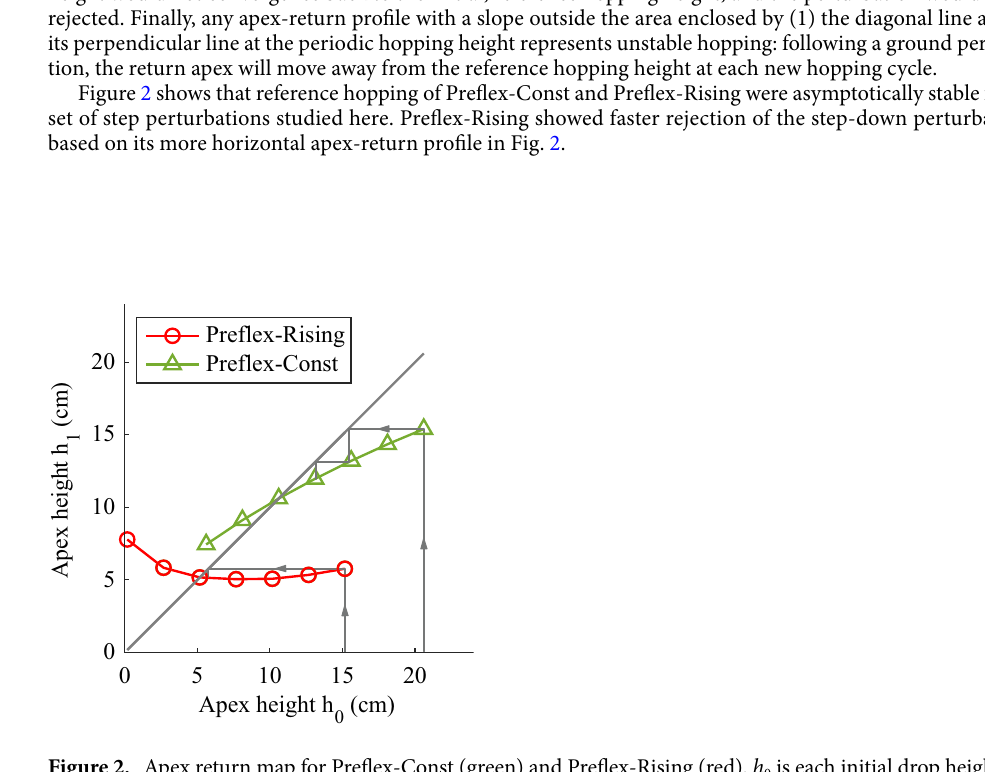
Figure 2. Apex return map for Preflex-Const (green) and Preflex-Rising (red). h 0 is each initial drop height tested in our study, and h 1 each associated return apex after one hopping cycle. Notice that h 1 would be the initial drop height for the following hopping cycle during continuous hopping. Intersections with the diagonal line represent periodic hopping heights. The rather horizontal return-map for Preflex-Rising around its periodic hopping height represents faster rejection of ground perturbations: the arrows indicate the faster convergence to periodic hopping within fewer hopping